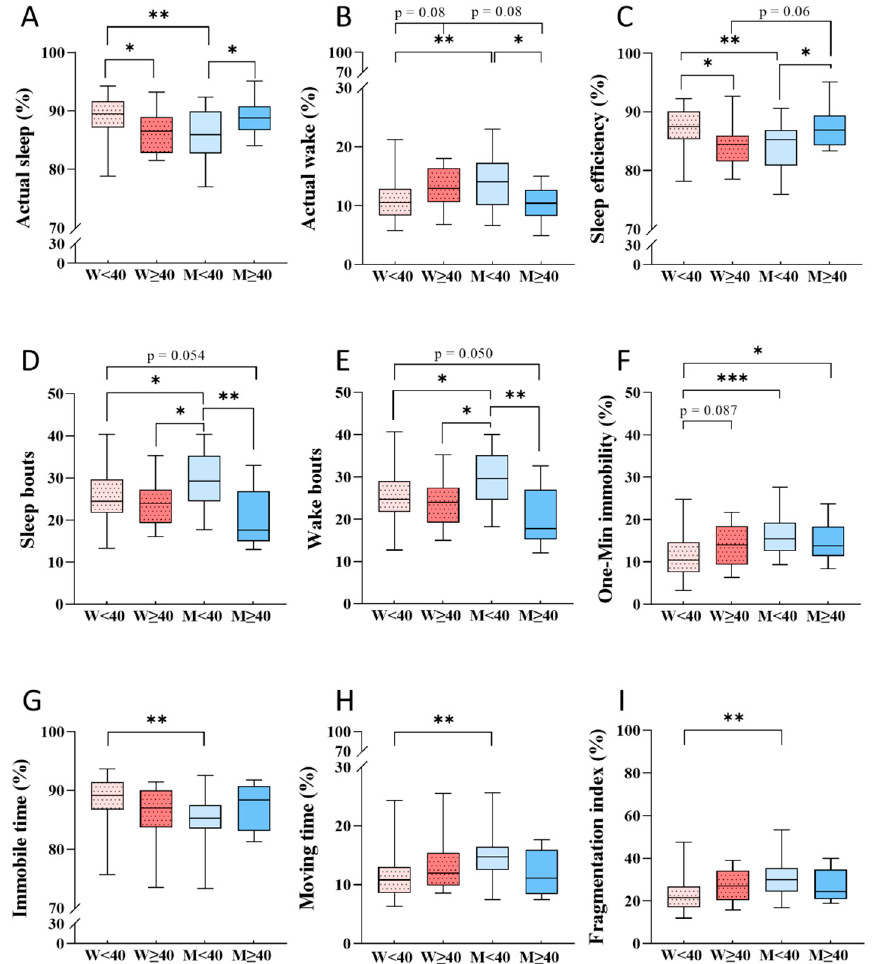
Figure 2. Differences in sleep parameters according to wrist actigraphy according to gender and age: ( A )—actual sleep (%); ( B )—actual wake (%); ( C )—sleep efficiency (%); ( D )—sleep bouts; ( E )— wake bouts; ( F )—one ‐ minute immobility (%); ( G )—immobile time (%); ( H )—moving time (%); ( I )— fragmentation index (%). Data are presented as boxplots with median, 25% and 75% quartile and minimum and maximum values. W < 40—women less than 40 years old ( n = 35); W ≥ 40—women 40 years and older ( n = 12); M < 40—men less than 40 years old ( n = 17); M ≥ 40—men 40 years and older ( n = 10). Statistical differences were compared by ANOVA with Fisher post hoc test, if parametric,or Kruskal ‐ Wallis with Dunn´s post hoc test, if nonparametric (* p < 0.05; ** p < 0.01; *** p < 0.001).